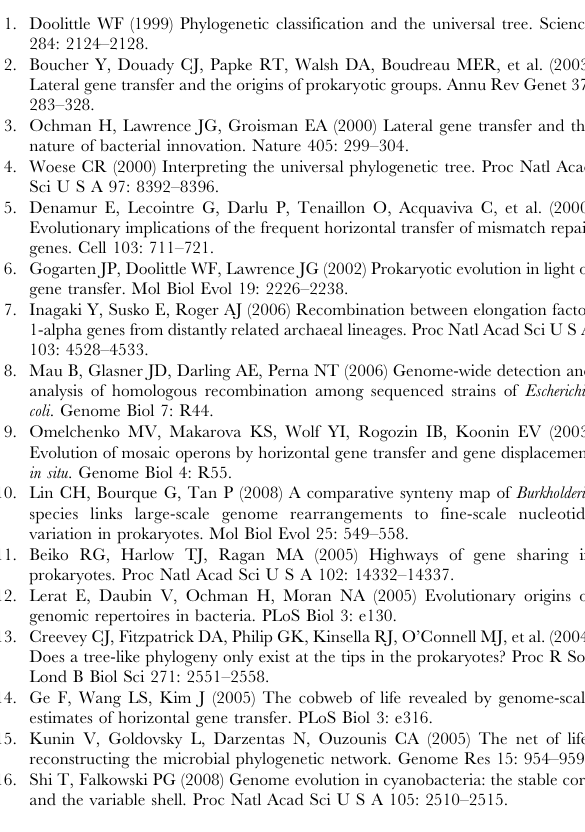
Figure S3 Distribution of the lengths of domain regions in the dataset. Figure S4 Relationship of the length of domain region (X-axis) and that of inter-domain region (Y-axis), shown for sequences in which recombination is inferred. The relationship is shown as (A) a heat map and (B) a dot plot. In the heat map, blue cells contain